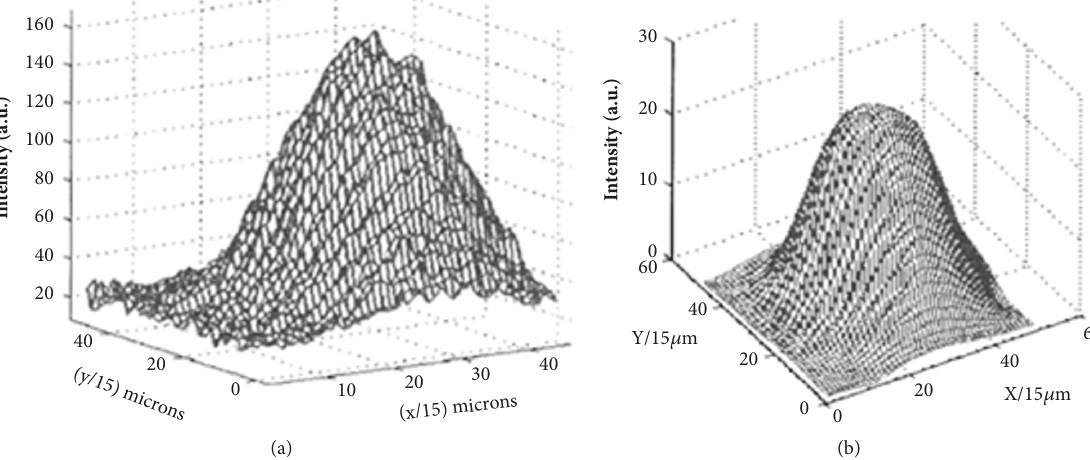
Figure 4: (a) YAG laser beam experimental spatial dependence, showing a myriad of distortions; (b) experimental results with a phase- conjugate mirror, showing beam cleanup to a 2D Gaussian profile [adapted from